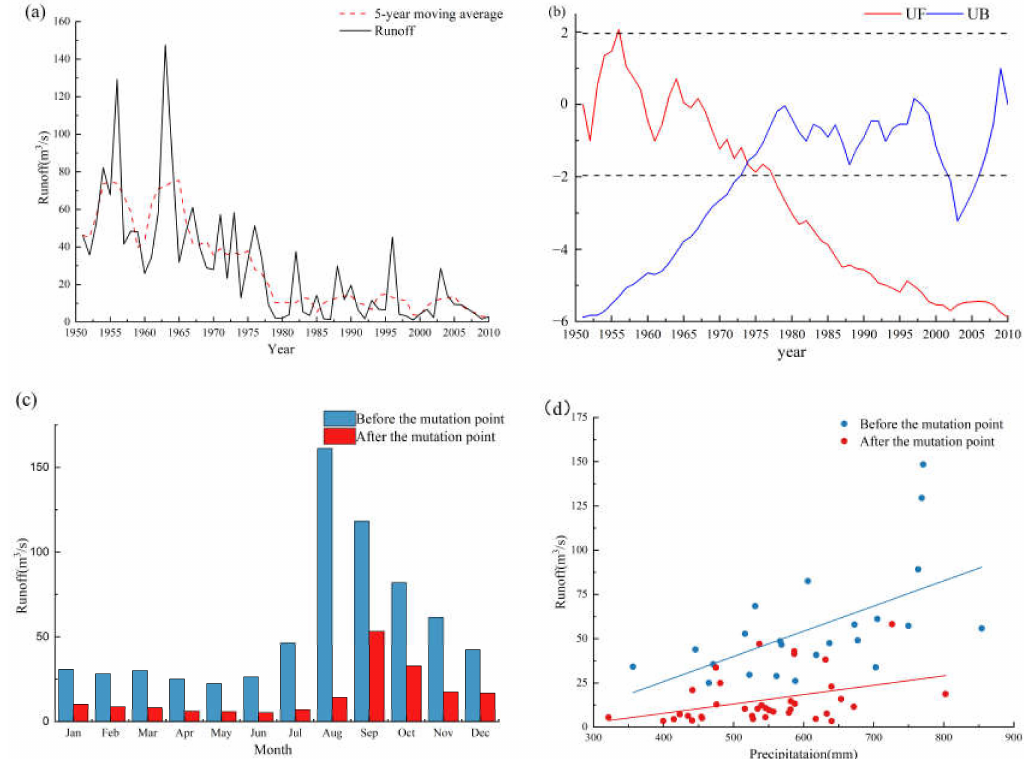
Figure 3. Mutation point test of the meteorological and hydrological elements. ( a ). Time series variation of Guantai runoff; ( b ). Mann–Kendall mutation test result of Guantai runoff; ( c ). Change in mean runoff before and after the mutation point; ( d ). Changes in rainfall runoff correlation before and after the mutation